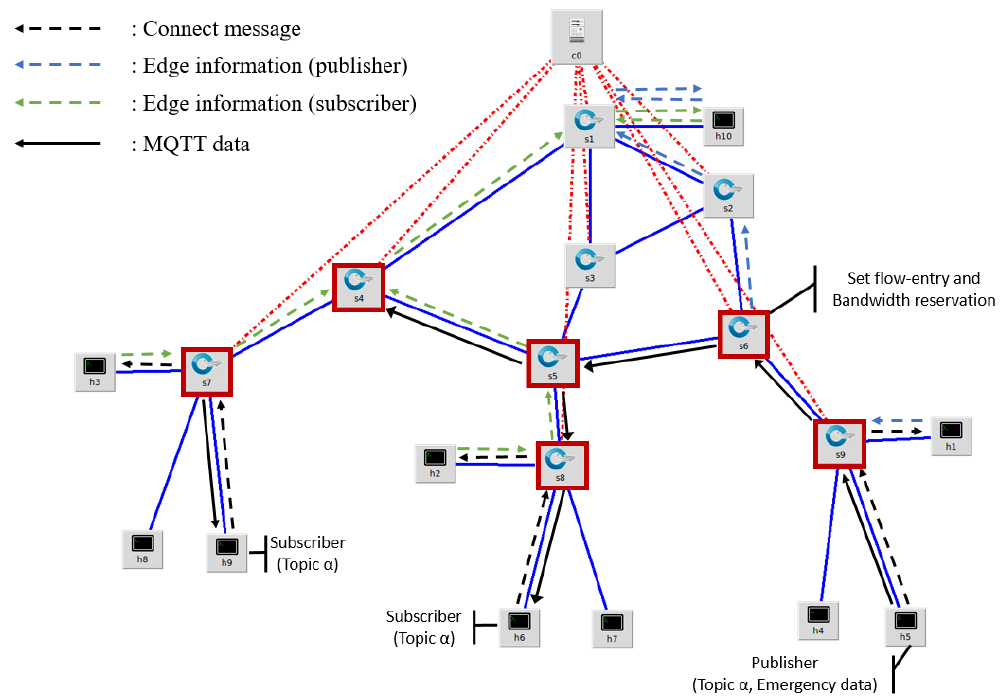
Figure 7. Example of message path of DM-MQTT in edge network.